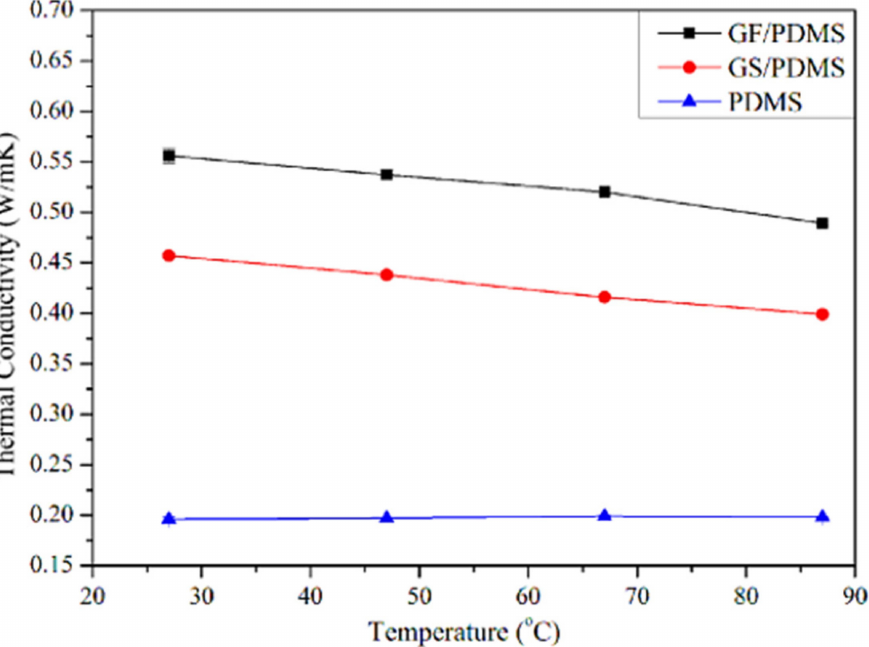
Figure 7. Thermal conductivity as a function of temperature. PDMS = poly(dimethyl siloxane); GF/PDMS = graphene nanofoam/poly(dimethyl siloxane); GS/PDMS = graphene sheet/poly(dimethyl siloxane). Reprinted with permission from Ref. [86]. 2015,